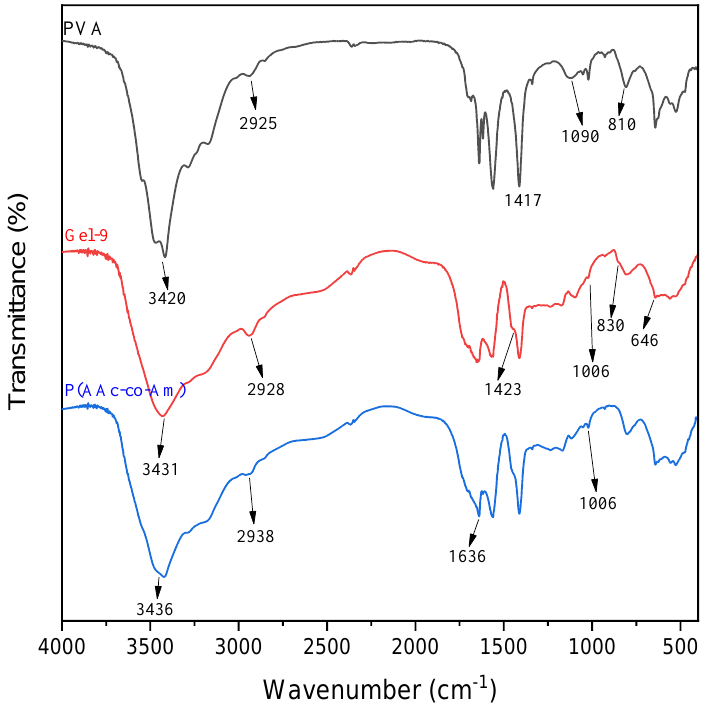
Figure 1. Fourier transform infrared spectroscopy (FT-IR) spectra of PVA, P(AAc- co -Am) and P(AAc- co -Am)/PVA double network hydrogel (Gel-9).